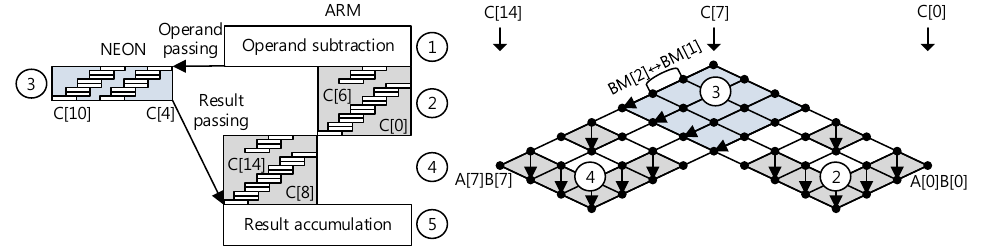
Figure 1: Unified 256-bit ARM/NEON multiplication at the word-level, 1 (cid:13) : operand subtraction; 2 (cid:13) 4 (cid:13) : two sub-products on ARM; 3 (cid:13) : sub-product on NEON; 5 (cid:13) : result